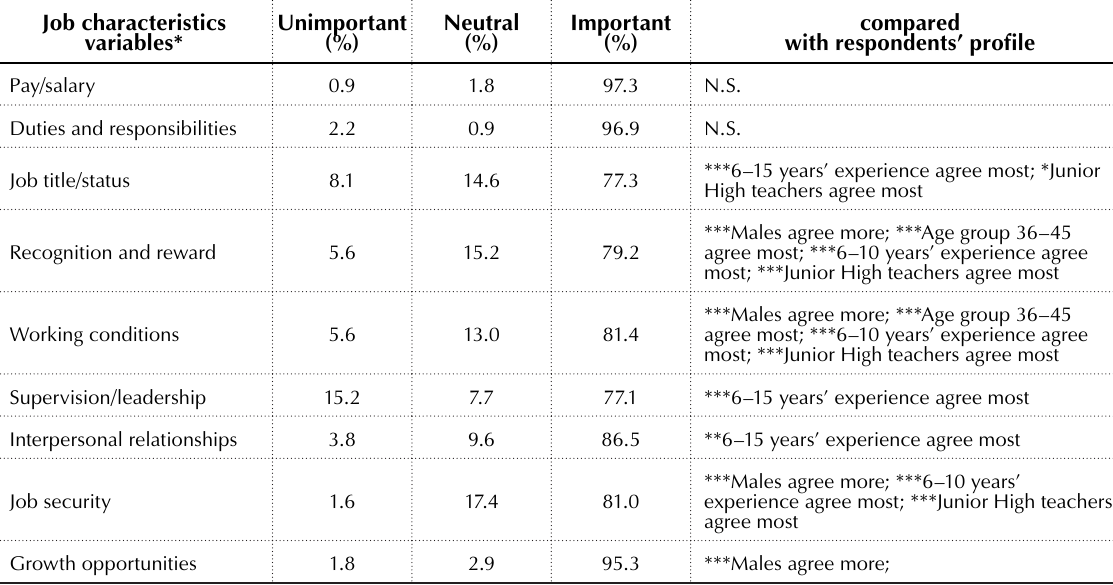
Table 5. Importance of job characteristics’ variables to work motivation compared with respondents’ profile (n =